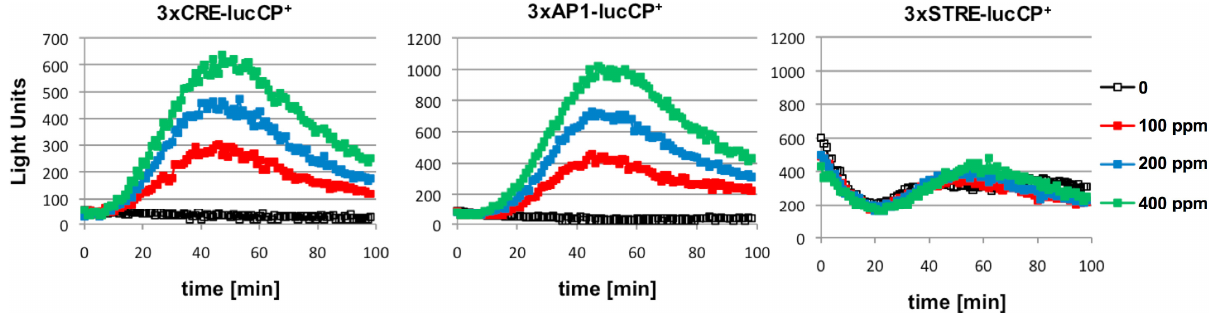
Figure 2. Citrinin activates gene expression from CRE and AP-1 promoter elements in a dose dependent fashion. Artificial promoter-luciferase constructs were used, which contained multiple repetitions of the same cis-element: CRE, AP-1 or STRE as indicated. The indicated citrinin doses were applied at time point 0 to the yeast cultures and the light emission continuously monitored. Data shown are mean values from three independent biological samples. SD <